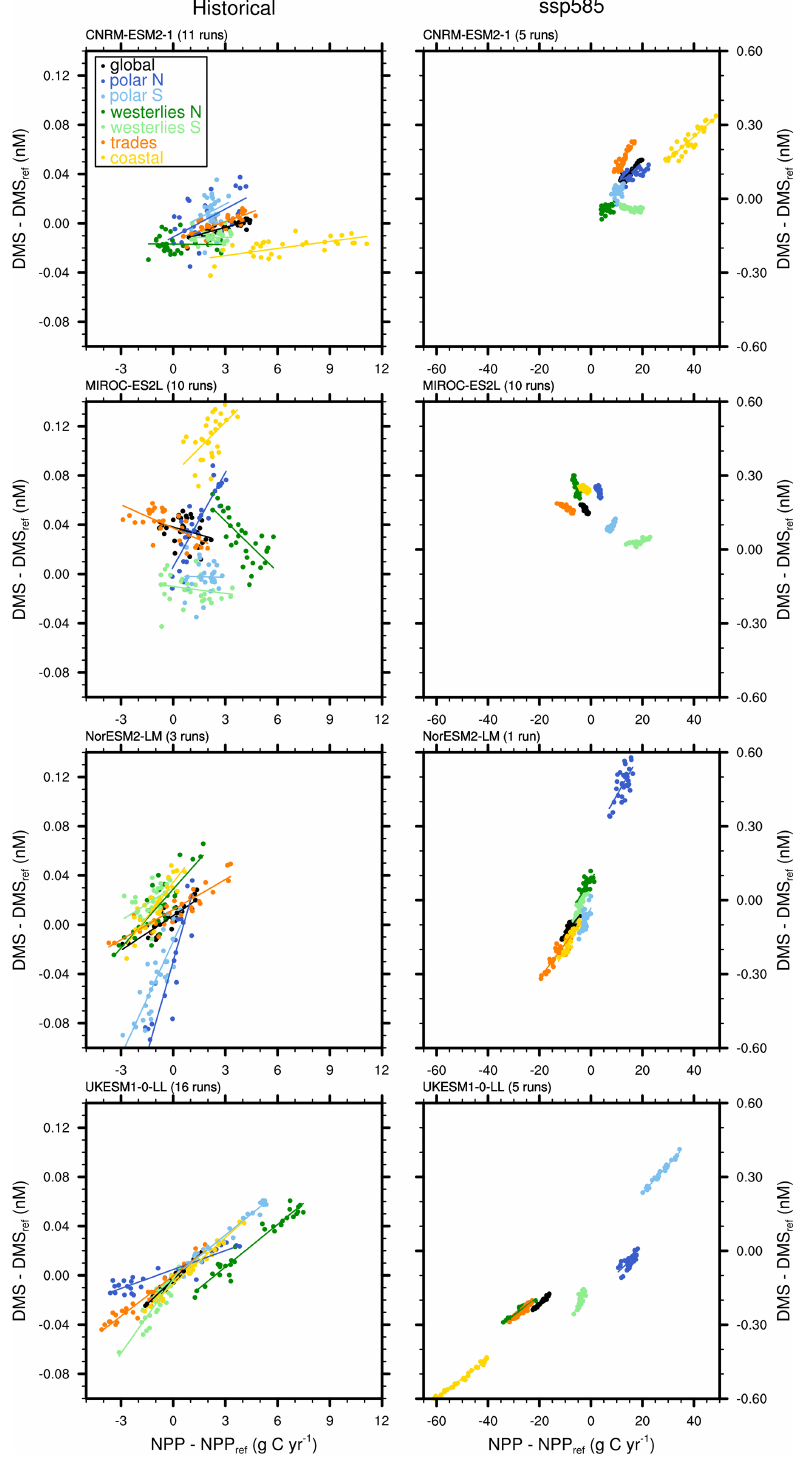
Figure 13. Scatter plot of change of DMS concentration as compared to the change in NPP as simulated by CMIP6 models over the historical 1980–2009 period (left column) and ssp585 2071–2100 period (right column). For both variables, the reference (DMS ref and NPP ref , respectively) is the mean value over 1850–1879. Each scatter plot displays global values (black dots) and the values in each of the six biomes (dark and light blue: polar N and S, dark and light green: westerlies N and S, orange: trades, yellow: coastal); see Fig. 5 for a mapping of these regions. Linear regressions are shown, and related information is given in Table 8. Mind the different scales between both